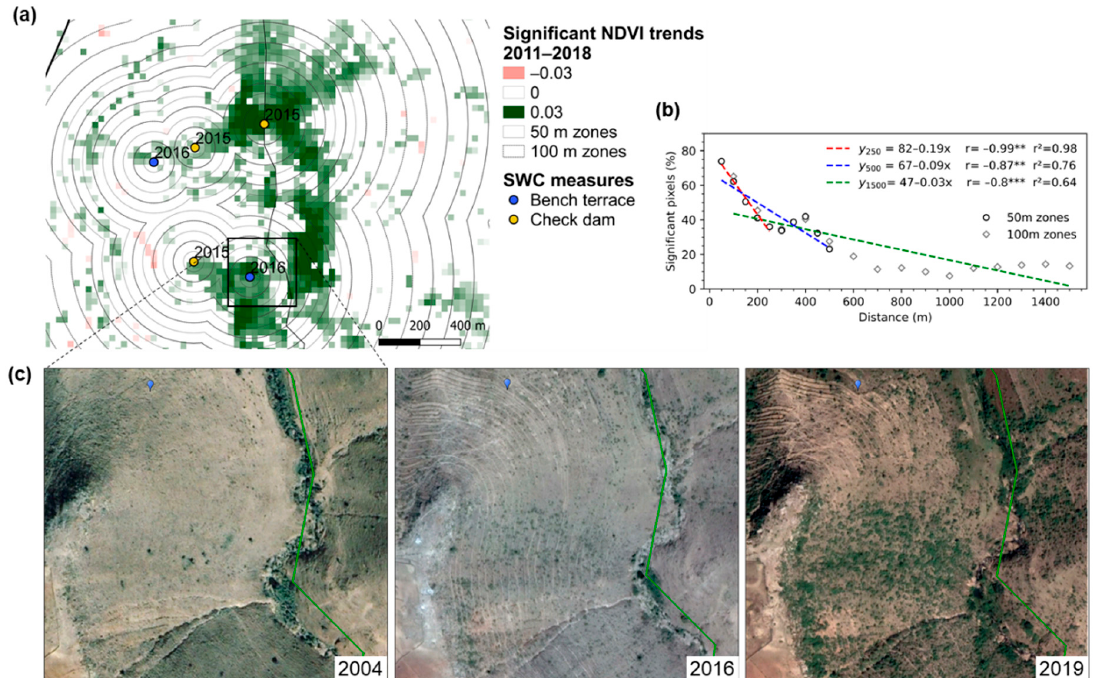
Figure 8. OLS regression of trends and the locations of SWC measures in the watershed of Tahtay Koraro. ( a ) Significant NDVI trends 2011–2018 with SWC points showing the year of completion; ( b ) Combined regression model for all check dams and terraces in the watershed for the proportion of significant increasing NDVI trends 2011–2018; ( c ) Multi-temporal Google Earth VHR images showing the zoom-in area with an increase in vegetation cover from 2004 to 2019 and the construction of terraces in 2016. ** p < 0.01, *** p <